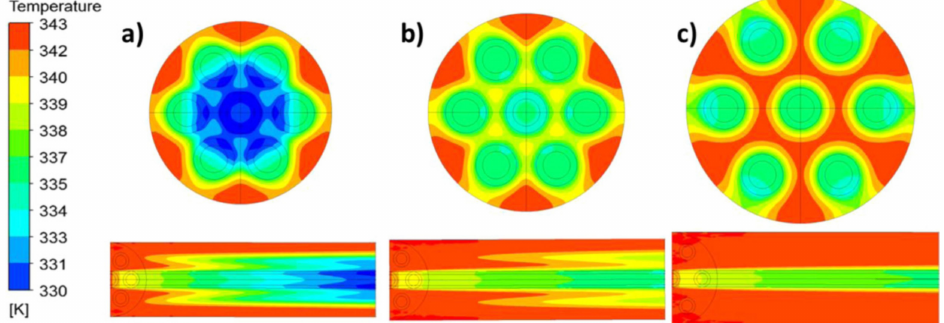
Figure 18. Temperature contours at the module outlet (cross-section) and from the inlet to outlet (axial profile) for module packing densities of ( a ) 2.4, ( b ) 1.8 and ( c ) 1.2 m 2 /m 3 [53]. Reproduced with permission from Elsevier,